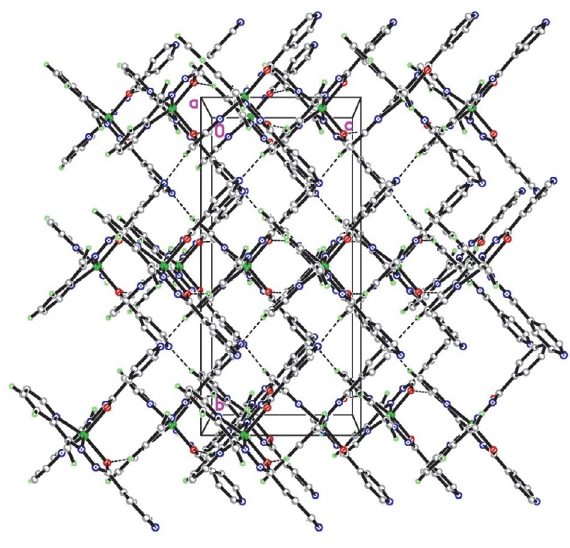
Fig. 2. Molecular packing structure of complex 1 , with hydrogen bonds drawn as dashed lines.